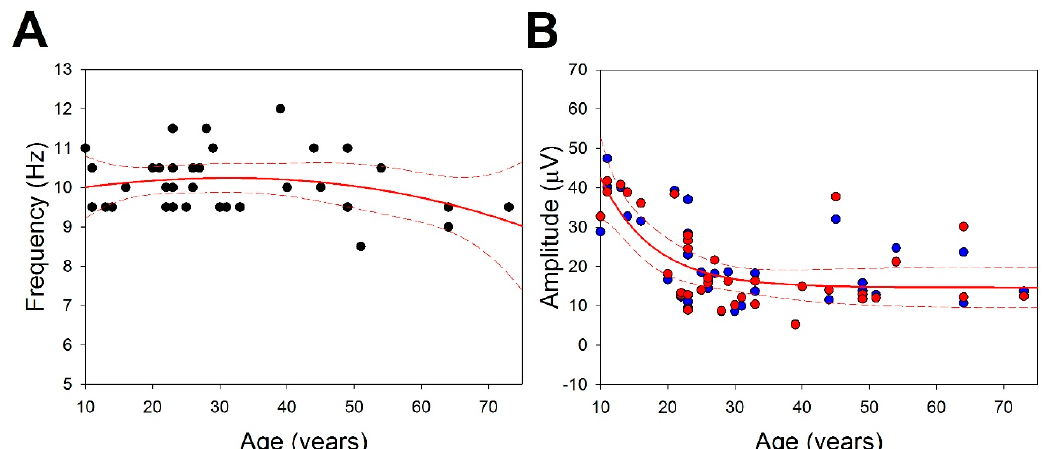
Figure 2. Features of PDR. ( A ) Peak frequency of PDR and regression function (solid red line) with 95% interval confidence (dashed lines); ( B ) Amplitude for the left (blue dots) and right (red dots) parieto-occipital channels. Negative exponential regression functions overlapped: red (r = 0.6890) and blue (r = 0.7011) for right and left hemispheres, respectively.